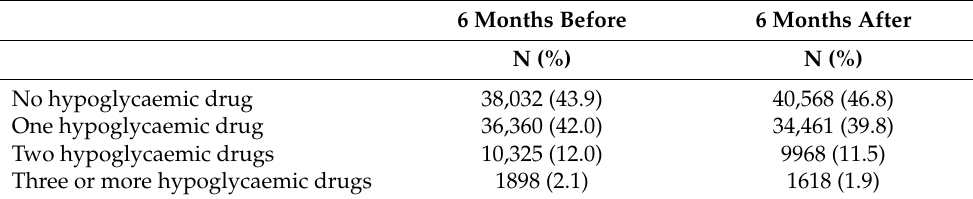
Table 3. Number of patients who do not use insulins or oral antidiabetics or who consume one or more.